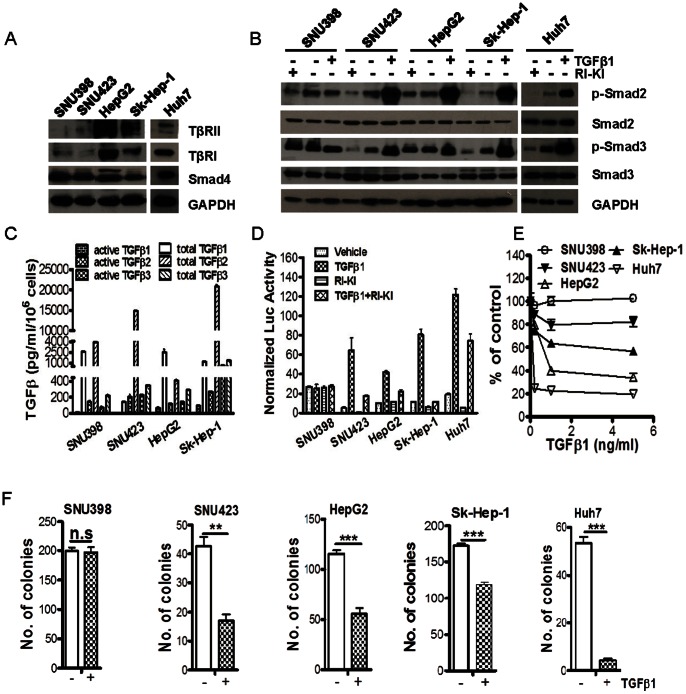
Status of TGF-β signaling pathway in five HCC cell lines.(A) Immunoblotting analysis for TβRII, TβRI and Smad4 in five HCC cell lines. (B) Immunoblotting analysis for Smad proteins in cell lysates of five HCC cell lines treated with or without 2 ng/ml TGF-β1 or 100 nM RI-KI for 1 hour. (C) Levels of the TGFβ isoforms in the media conditioned by four HCC cell lines were examined with the Duoset ELISA kit. Each data point represents mean ±SEM from three independent wells. (D) SBE-luciferase assay for TGF-β sensitivity in HCC cells. Cells were co-transfected with a TGF-β-responsive promoter-luciferase reporter (pSBE4-Luc) and a β-galactosidase (β-gal) expression plasmid and then treated with or without 2 ng/ml TGF-β1 or 100 nM RI-KI for 24 hours. Each data point represents mean±SEM from three independent transfections. Luciferase units in cell lysates were normalized to β-gal activity. (E) MTT assay for the effect of indicated doses of TGFβ1 on the proliferation of HCC cells after a 5-day treatment. Each data point represents mean±SEM from 4 independent wells. (F) soft-agar colony formation ability was assessed in HCC cells with or without 2 ng/ml TGFβ1 treatment for 14 days. Colonies in each culture well were counted after staining. Each data point represents mean±SEM from three independent wells. **, p<0.01; ***, p<0.001; “ns” means “no significance”.